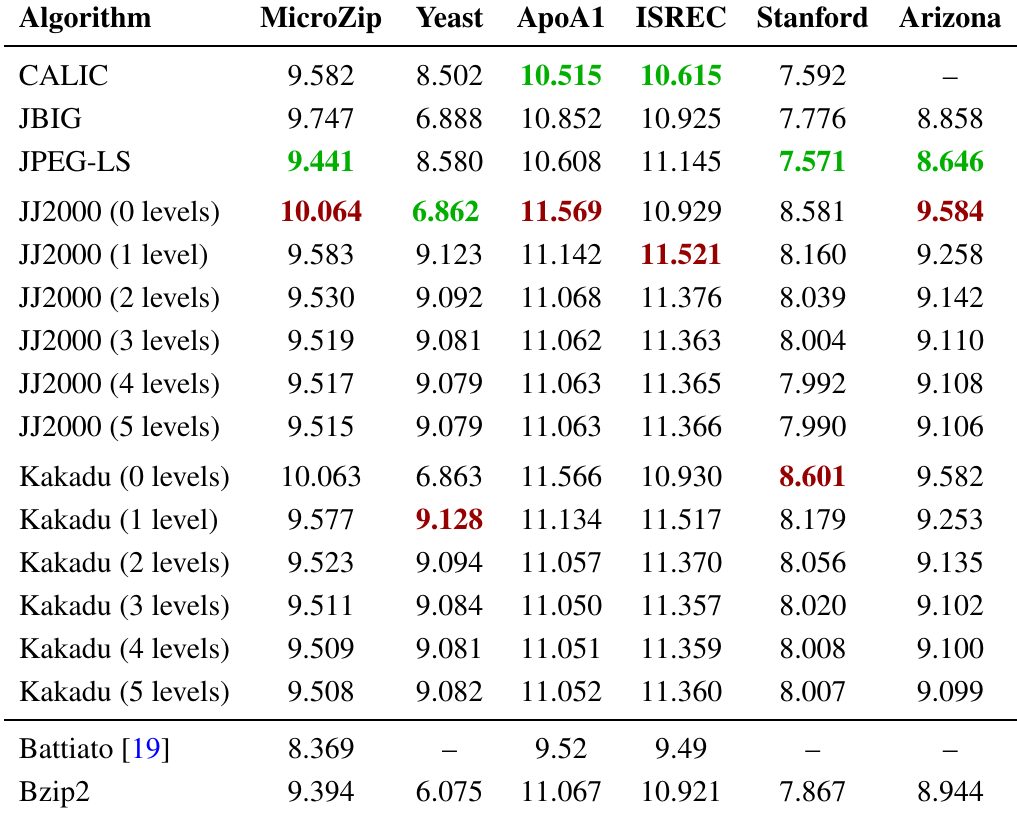
Table 6. Lossless compression results in bpp for generic (not microarray-specific) image compressors and individual image compression, obtained by the authors. Standard compression parameters have been used for all algorithms except for JPEG2000, where different DWT decomposition levels have been applied. All images are 16 bpp. Best results are highlighted in green and worst results in red . Results for the best microarray-specific technique and the best general compressor are repeated at the bottom for ease of